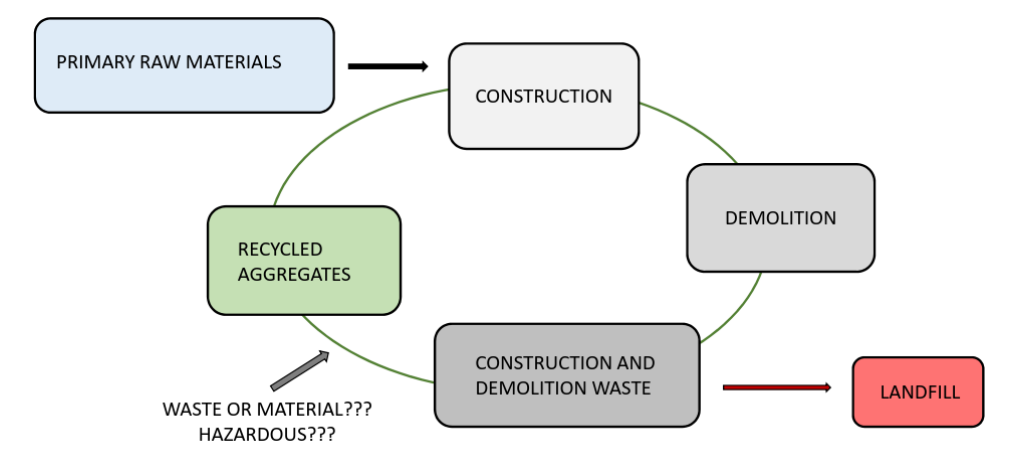
Figure 1. Life cycle and recycling possibilities of primary raw materials.